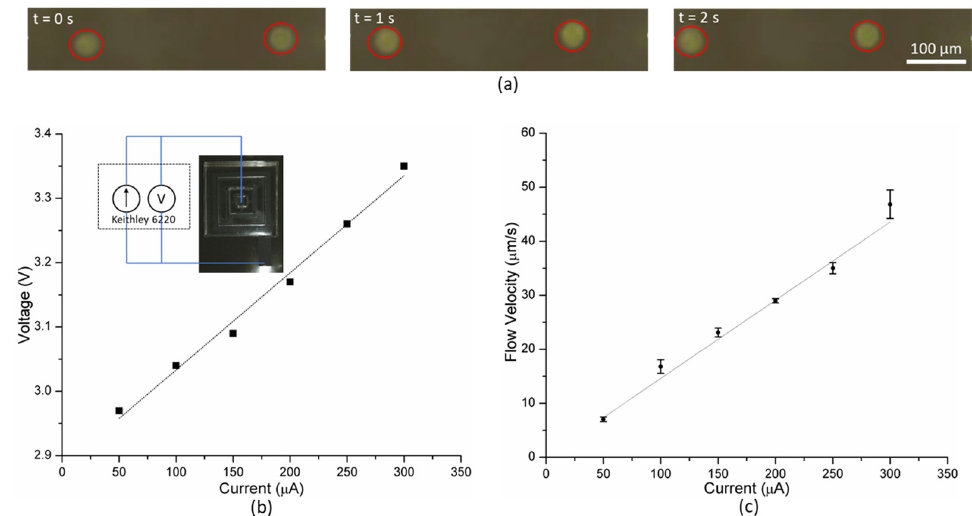
Figure 4. ( a ) Time lapse showing fluid motion in the integrated MHD pump, ( b ) V vs. I; the inset shows the setup used to drive the MHD pump, and ( c ) flow vs. current characteristics of MHD